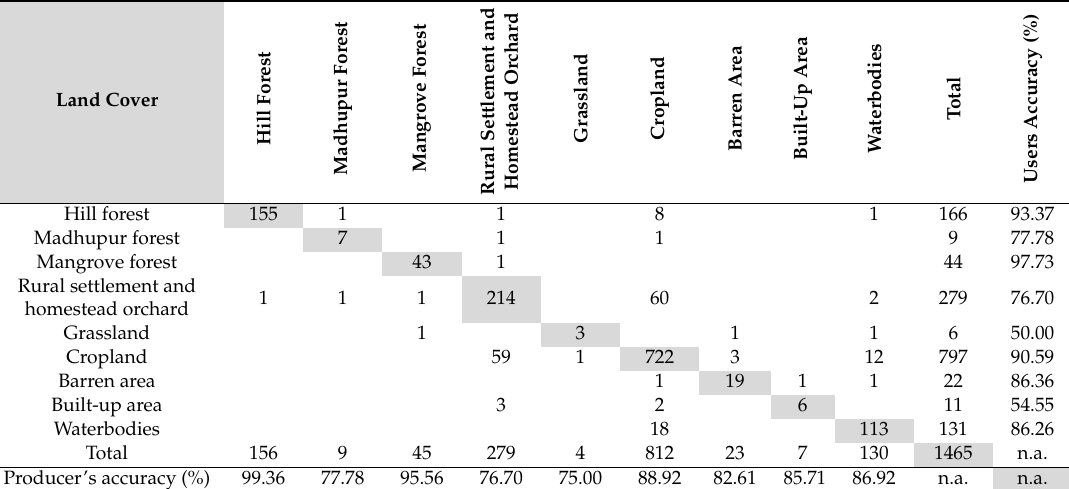
Table 2. Error matrix for the land cover map of